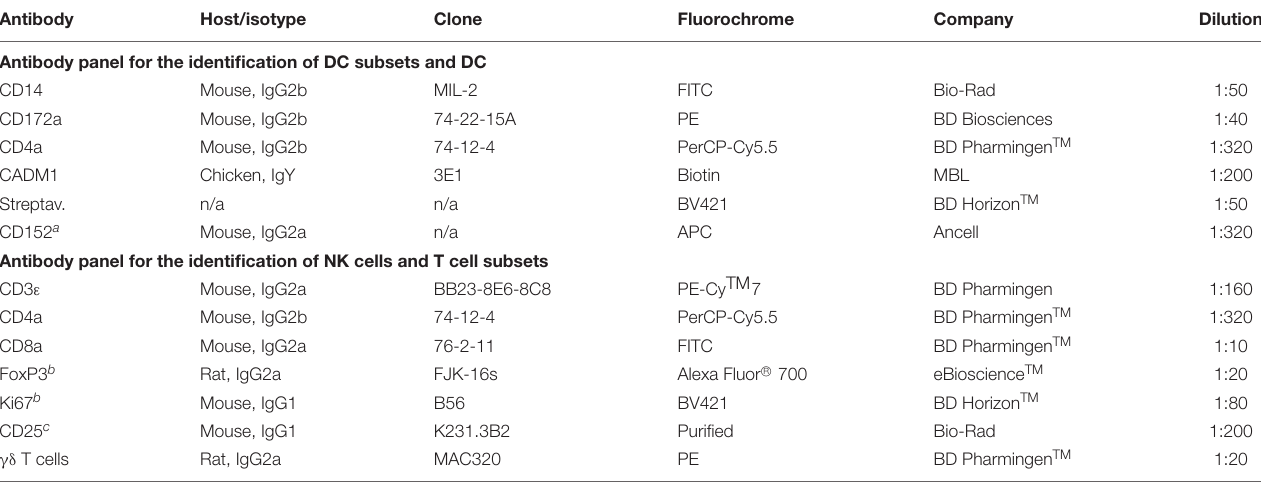
TABLE 2 | List of antibodies used for identifying DCs, NK cells, and T cells in PBMCs and MLN cells.